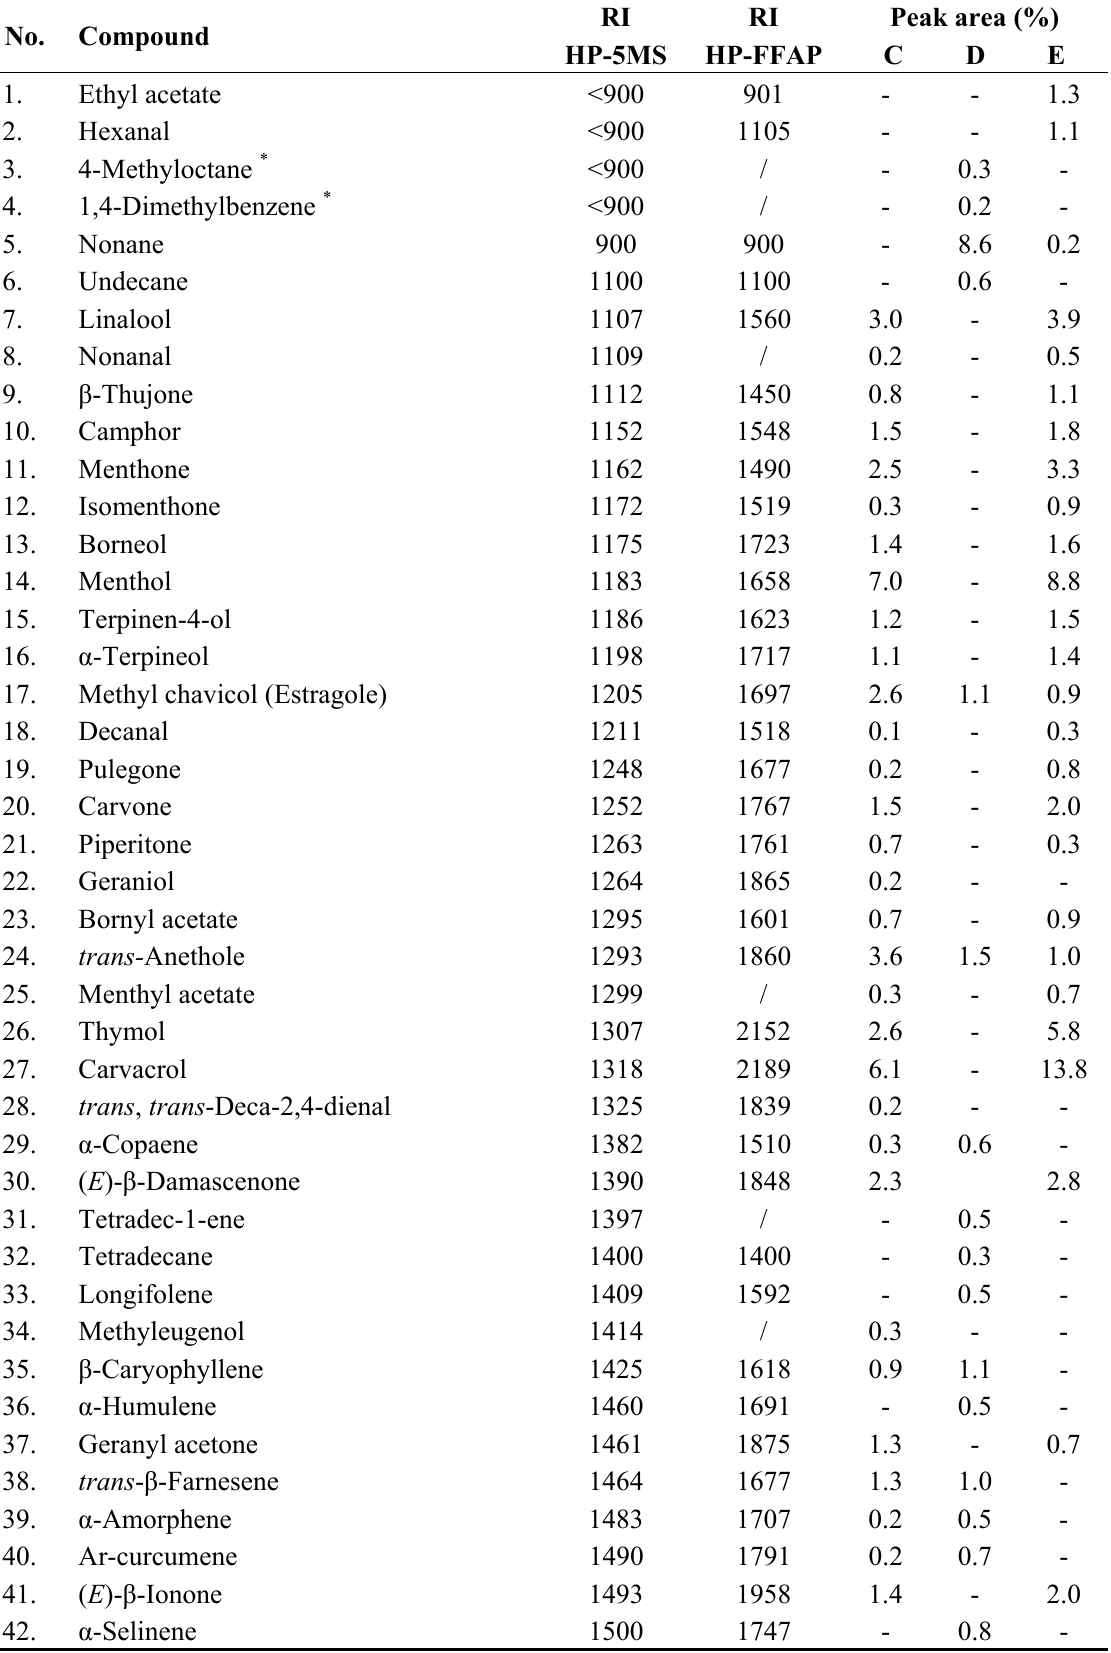
Table 2. The essential oil composition of C. erythraea ( C ) and its fractions: D –non-polar fraction and E –polar